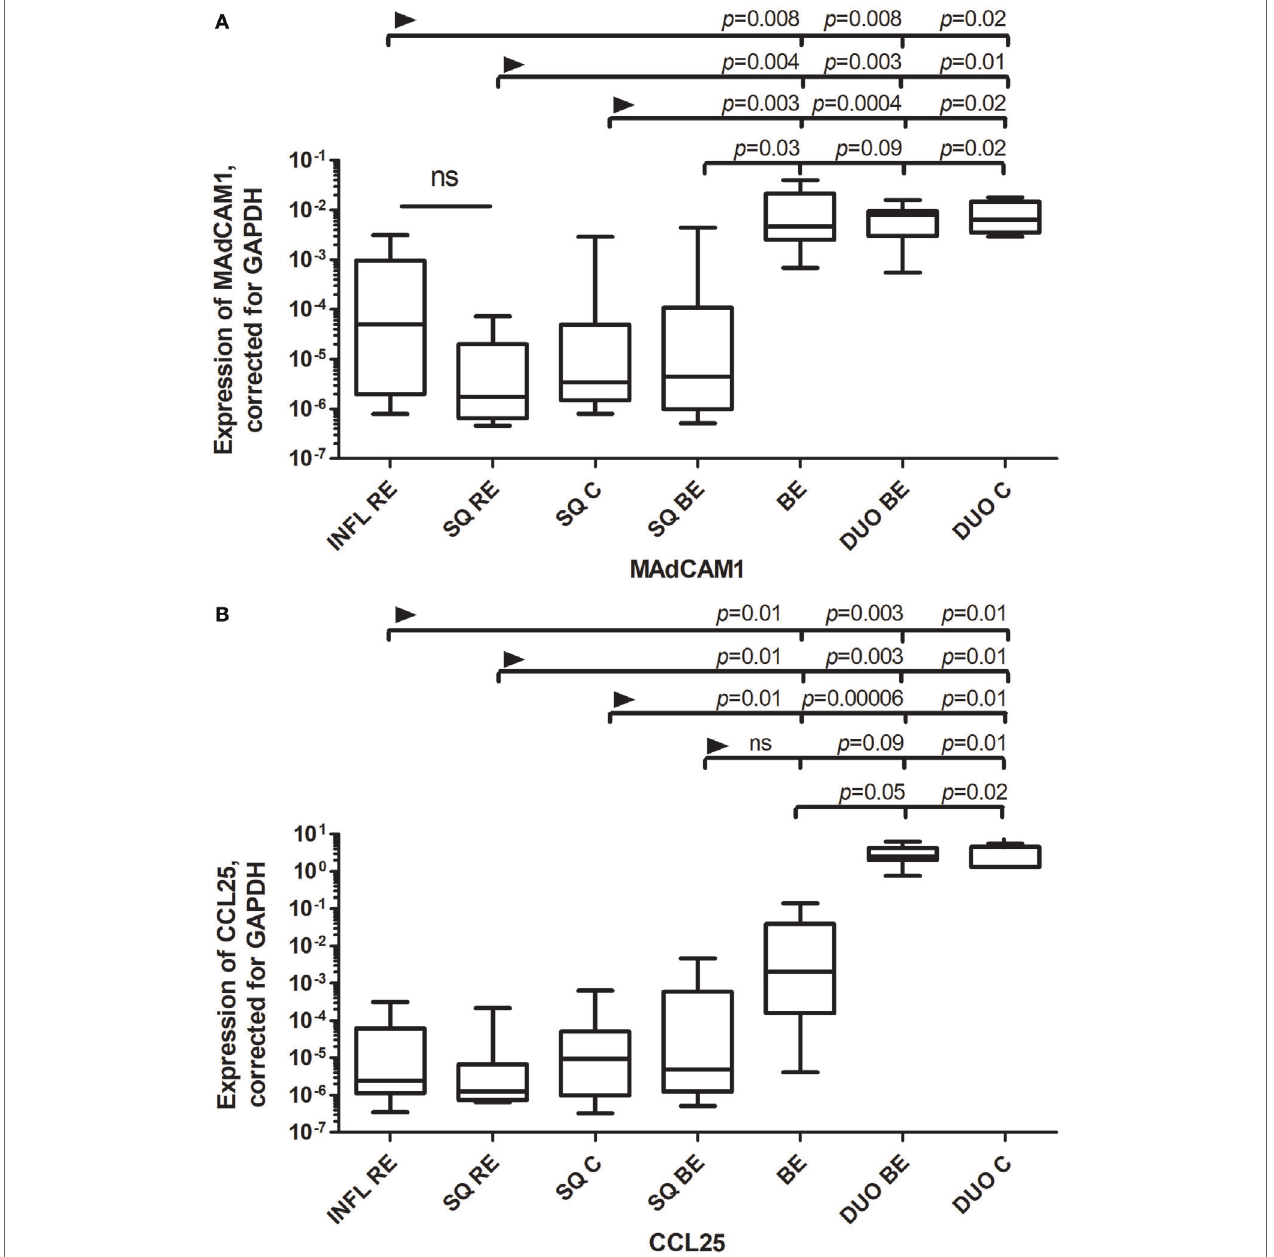
FigUre 1 | (a) Similar expression of MAdCAM1 Barrett’s esophagus (BE) and duodenal tissues. (B) Expression of CCL25 in BE is intermediate between squamous esophageal tissue and duodenal tissue. Real-time (RT) PCR was performed on a total of: reflux esophagitis (RE) biopsies (INFL RE, n = 9), non-inflamed squamous esophageal epithelium from RE patients (SQ RE, n = 9), squamous esophageal epithelium from controls ( n = 12), squamous esophageal epithelium from BE patients (SQ BE, n = 10), BE biopsies from BE patients (BE, n = 11), duodenal biopsies from BE patients (DUO BE, n = 10), and duodenal biopsies from controls (DUO C, n = 5). Expression of MAdCAM1, corrected for GAPDH, 2 −Δ CT ± SEM, is represented on the y -axis in (a) . Expression of CCL25 corrected for GAPDH, 2 −Δ CT ± SEM is represented on the y -axis in (B) . The Kruskal–Wallis test was used to compare all the groups ( p < 0.0001), p -values from comparing individual groups were obtained by using Mann–Whitney U test in case of individual groups and Wilcoxon signed rank test for different tissue types from the same patient. Adjustment for multiple comparison was conducted by Benjamini–Yekutieli